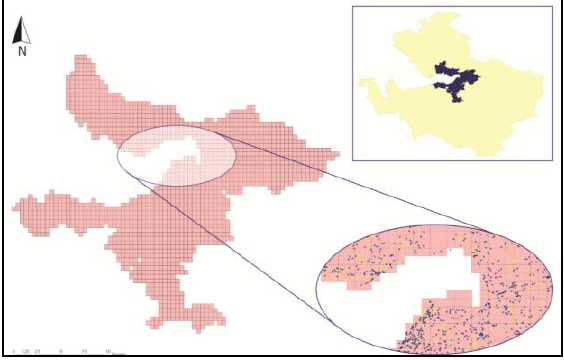
Figure 5. 400x400m cells for the grid scale area For grid scale analysis, descriptive statistics of the variables per grid cells are presented in Appendix